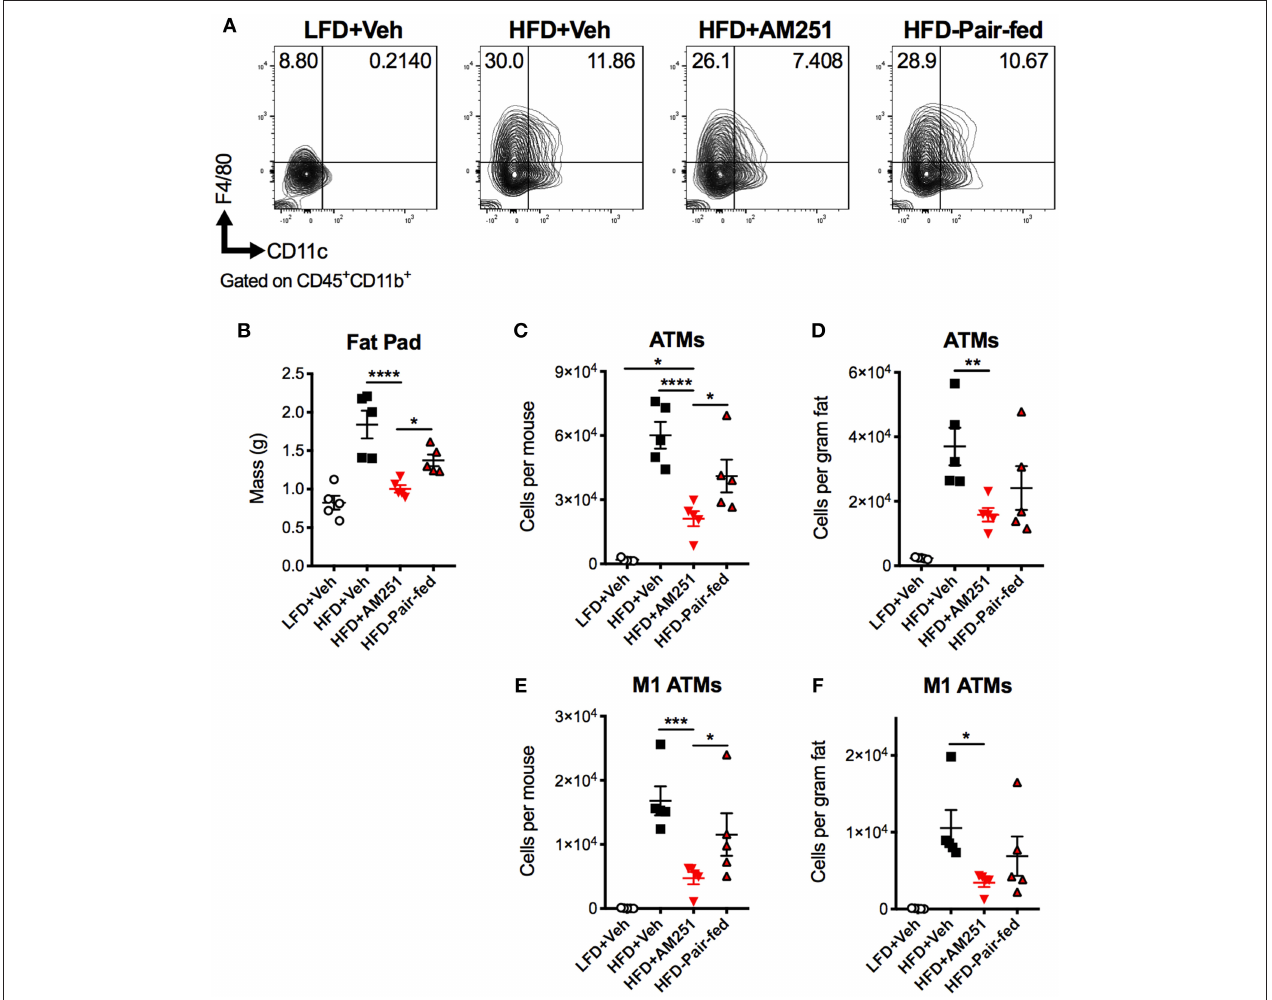
FIGURE 2 | CB1 blockade reduces abundance of pro-inflammatory macrophages in epididymal fat. HFD-fed obese mice were treated with the CB1 antagonist AM251 (10mg/kg) as described in Figure 1 legend. Epididymal fat SVFs from AM251-treated DIO mice were analyzed by flow cytometry. CD45 + CD11b + F4/80 + cells are considered as “ATMs”. CD45 + CD11b + F4/80 + CD11c + cells are depicted as “M1 ATMs.” (A) Contour plots of ATMs. (B) Epididymal fat mass. (C) Total epididymal fat ATMs per mouse. (D) ATMs per gram of fat. (E) Total epididymal fat M1 ATMs per mouse. (F) M1 ATMs per gram of fat. Data are mean ± SEM. N = 5 mice/group. Significance was determined by one-way ANOVA. **** P < 0.0001, *** P < 0.001, ** P < 0.01, * P < 0.05.